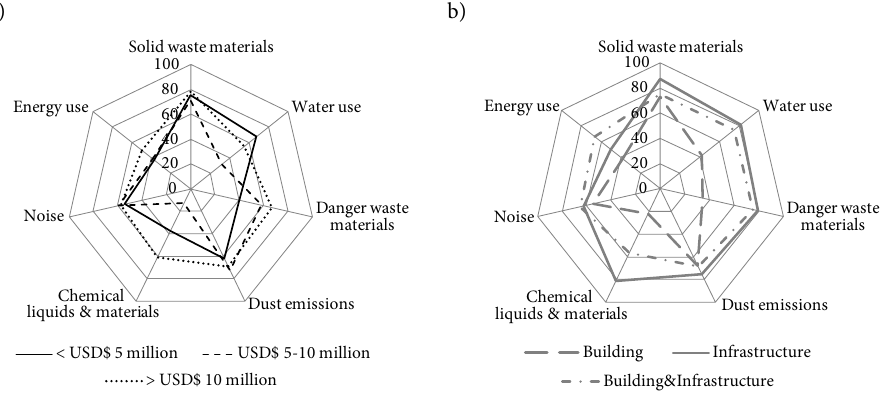
Fig. 2. percentage of projects in which SC actions have been implemented in the last three years, grouped by a) companies’ annual gross revenue, and b) companies’